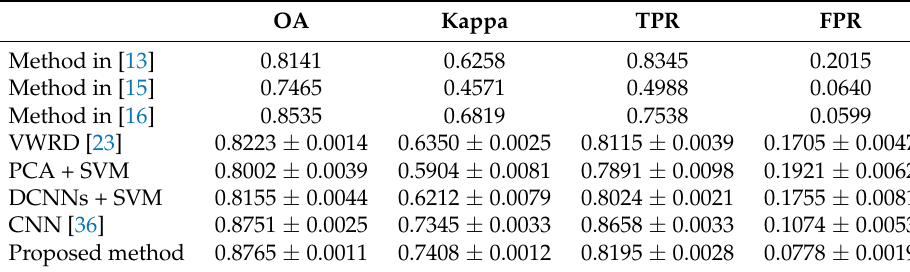
Table 3. Average performances of different methods using the Google Earth